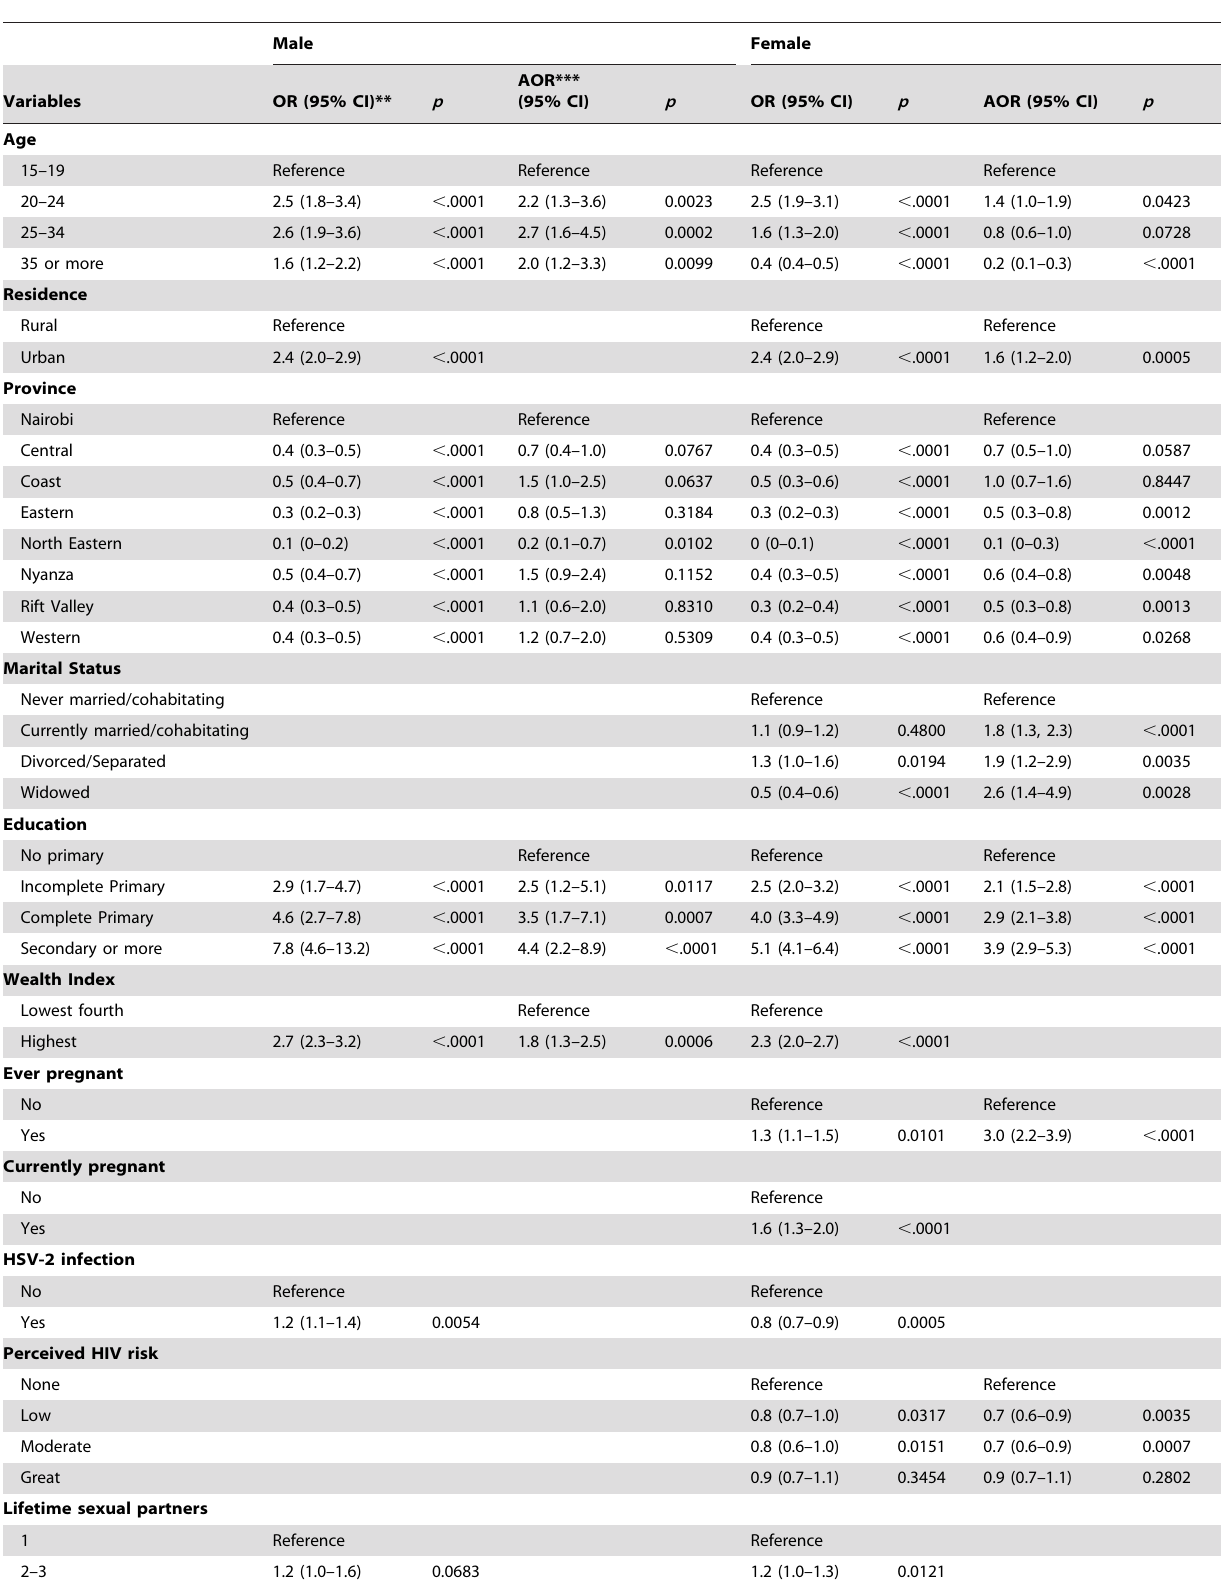
Table 2. Unadjusted* and adjusted odds ratios for factors associated with ever testing for HIV from gender-specific models, Kenya AIDS Indicator Survey